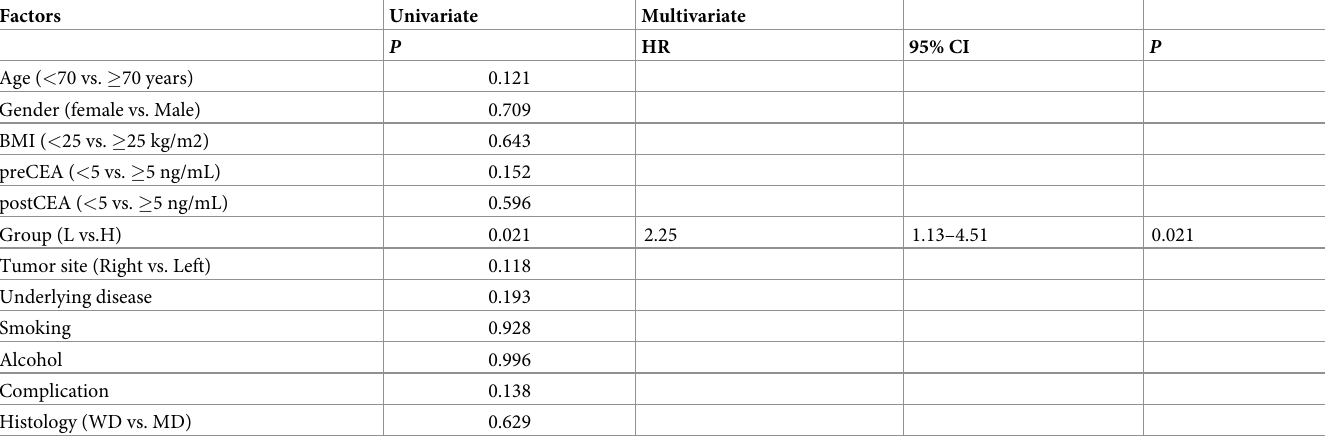
Table 7. Uni- and multivariate analysis of risk factors associated with recurrence using Cox regression model in patients without diabetes.